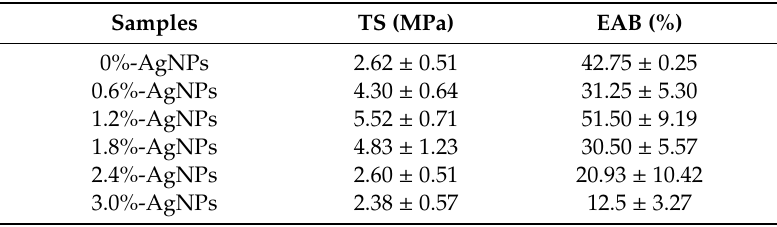
Table 3. Tensile strength (TS) and elongation at break (EAB) of FK / PVA / PEO composite nanofibers with di ff erent AgNPs